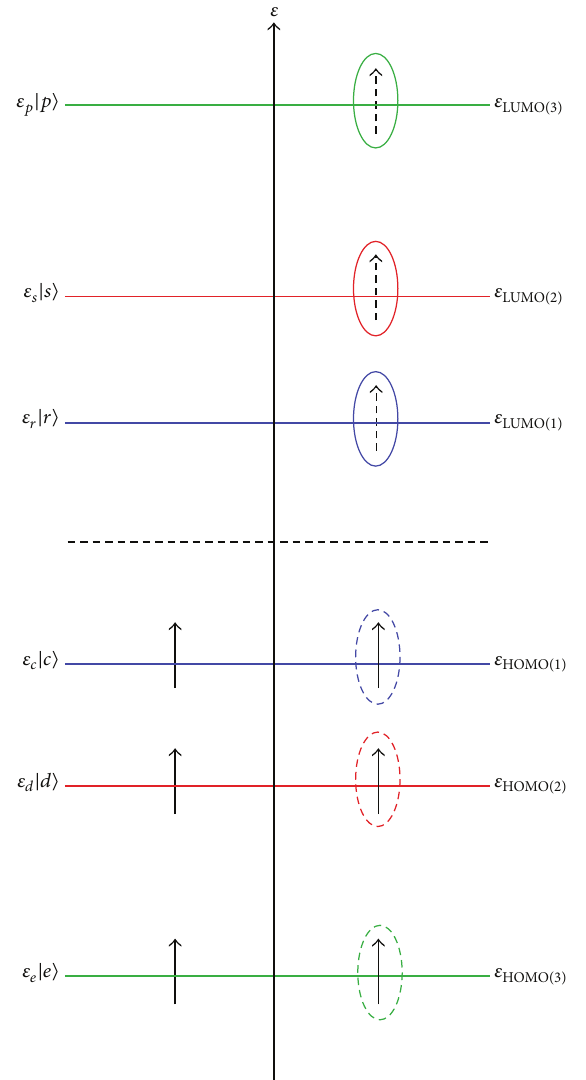
Figure 1: The paradigmatic in silico spectra of the first three highest occupied and lowest unoccupied molecular orbitals illustrating the respective, successive, ionization and affinities energies as provided by Koopmans’ theorem. Note that KT implies ionization and affinity of one electron on successive levels and not of successive electrons on levels; see the marked occupied and virtual spin